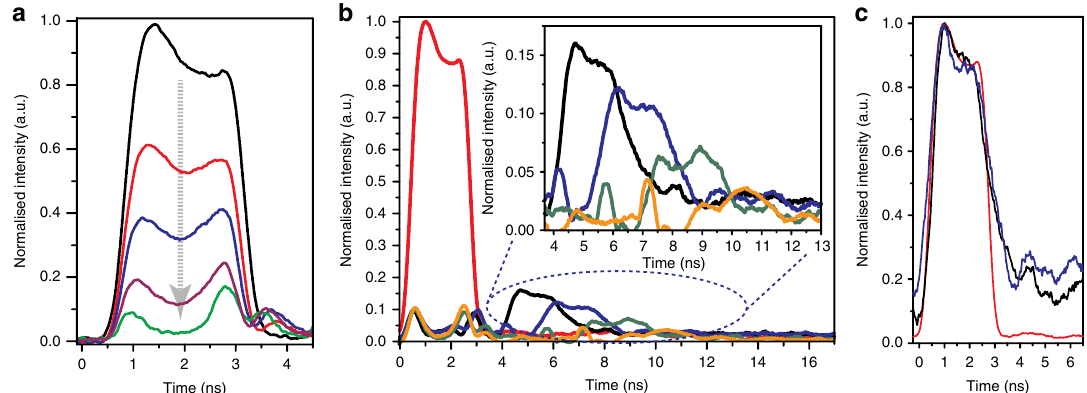
Fig. 2 Store and retrieval process with tunable storage time. a Storing process: the optical data pulse is depleted by the counter-propagating write pulse, transferring the carried information to the acoustic phonon. The curves show the transmitted data pulse for different write pulse powers: black : original data, red : 1.1 W, blue 2.0 W, purple : 3.0 W, green : 4.7 W. Depletion of more than 90% can be achieved. b Retrieved data pulses after different storage times. The inset shows a zoomed-in version of the retrieved data pulses. c Original data pulse ( red ) super-imposed with the retrieved data pulses after 3.5 ns ( black ) and 5.5 ns ( blue ) respectively; the details of the original shape can be distinguished in the retrieved